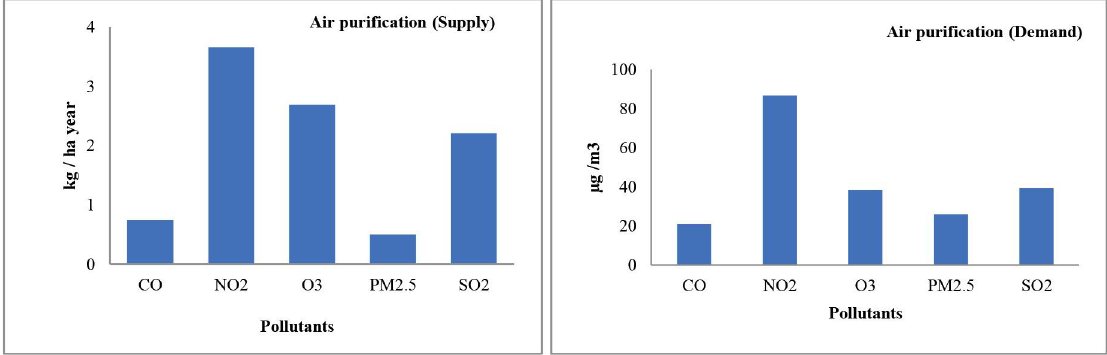
Fig 7. Results for air purification supply and demand (the value of CO in supply diagram is based on thousands) indicators for the case study.